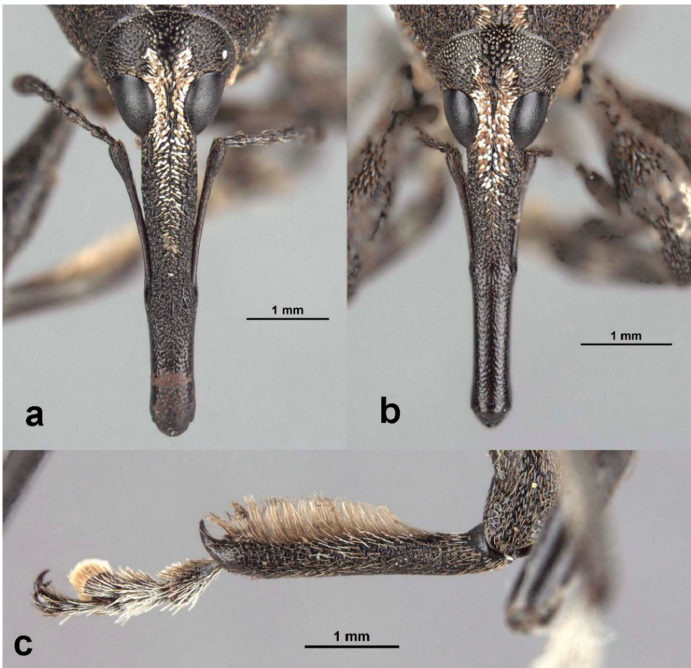
Figure 9. Ilacuris papuana : ( a ) rostrum of male, dorsal aspect; ( b ) rostrum of female, dorsal aspect; ( c ) protibia of male, anterior aspect.